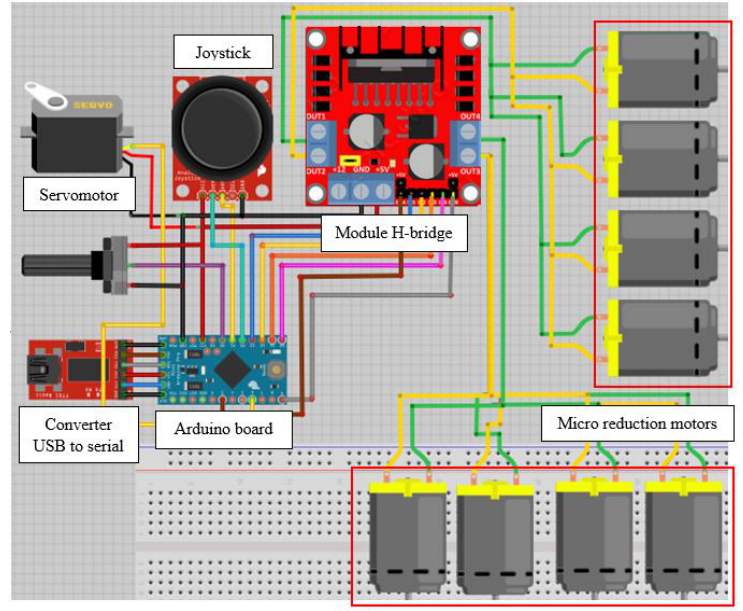
Figure 8. Control hardware design for the proposed robot in Figure 6.